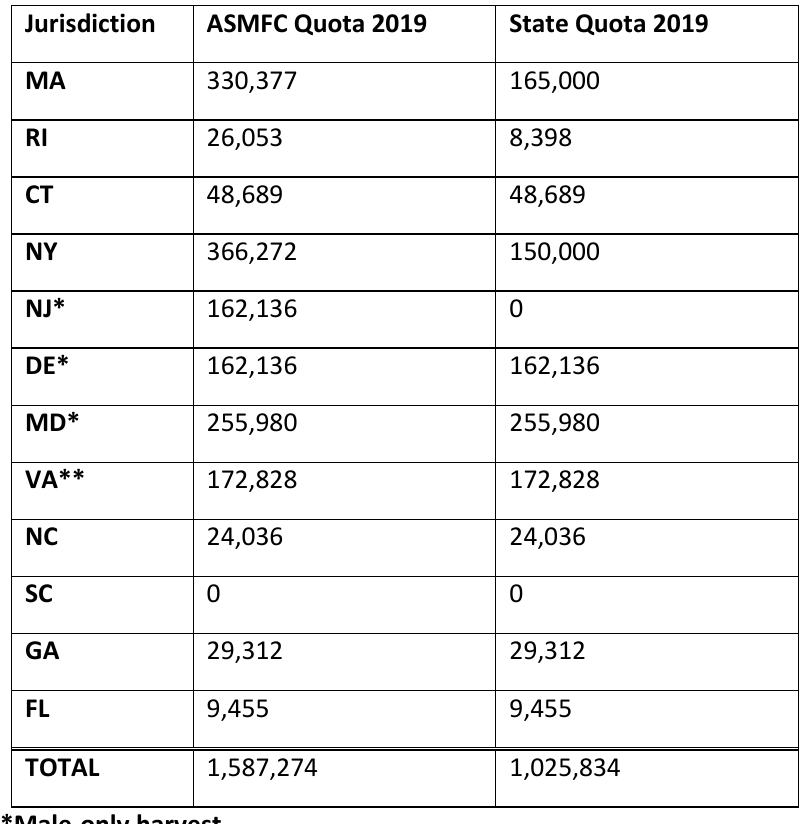
Table 2. State bait harvest quotas for 2019 as determined by the interstate FMP (ASMFC) and state-specific regulations